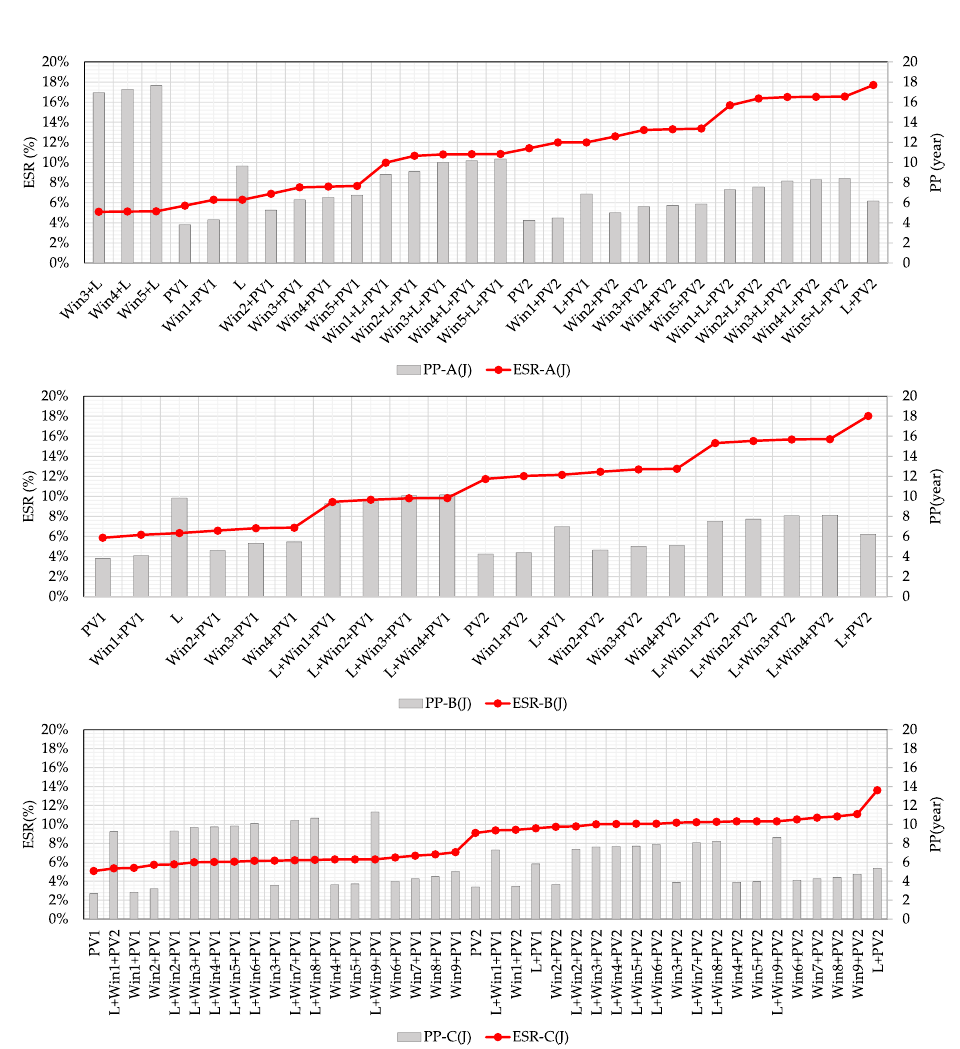
Figure 10. ESR trend within 20 years of PP according to ECM combinations for J region as an example.